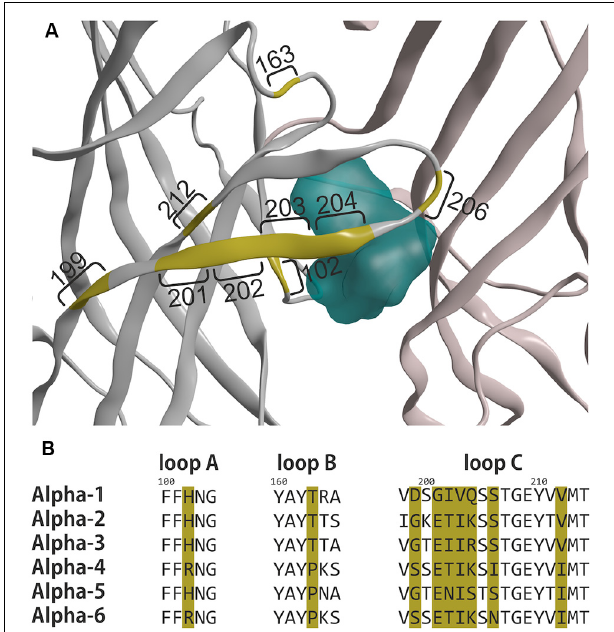
FIGURE 6 | Differences in the principal faces of α 1 and α 6 subunits. (A) Ribbon depiction of the α 1+/ γ 2 − ECD binding site from 6HUP. Segments colored in yellow represent amino acids, which differ between α 1 and α 6. Numbers indicate the number of the amino acid according to the numbering in 6HUP. The molecular surface of diazepam in the pocket is rendered in cyan to indicate the position of the variable amino acids concerning the space occupied by the ligand. (B) Partial alignment of sequences containing the different amino acids, depicted in (A) . All α isoforms are displayed with the positions of the amino acids, which differ between α 1 and α 6 colored in yellow. Amino acid numbering corresponds to 6HUP and represents the mature human α 1